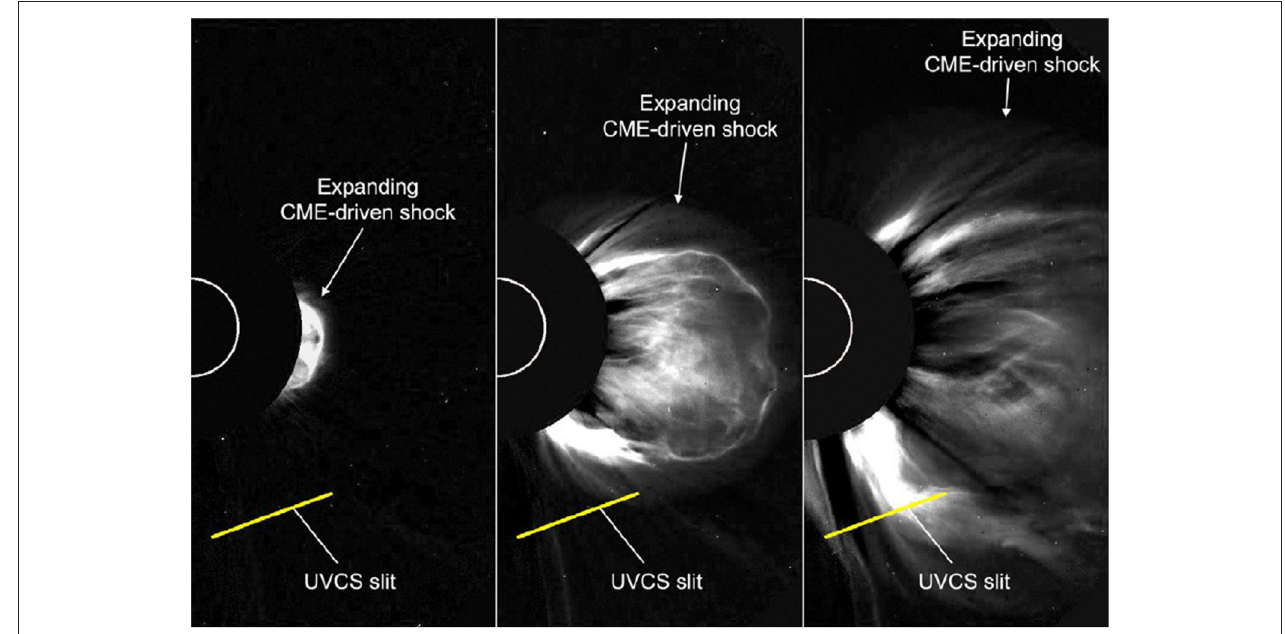
FIGURE 1 | The expansion of a CME-driven shock wave as observed in the LASCO/C2 WL coronagraph (Bemporad and Mancuso,